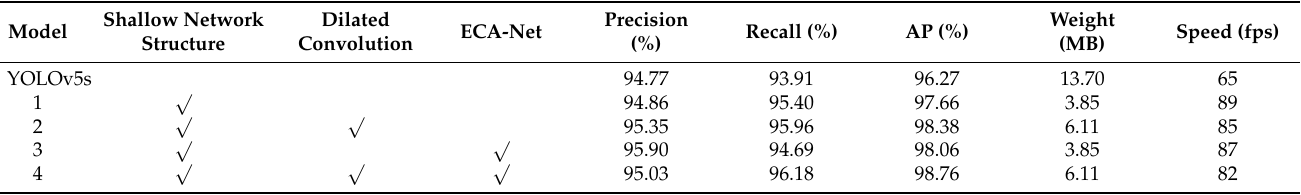
Table 4. Comparative ablation experiments using several improved method